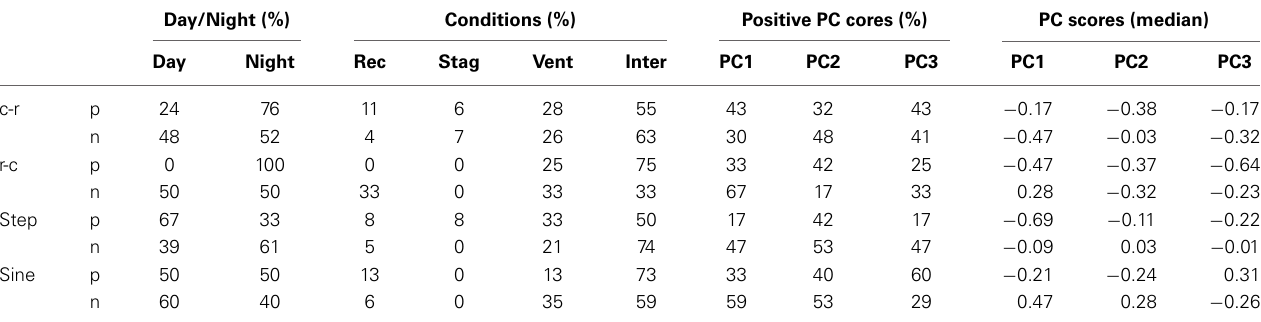
Table 2 | Statistics of the identified temperature shapes according to the day period, status of the flow field and the dominant surface pattern.